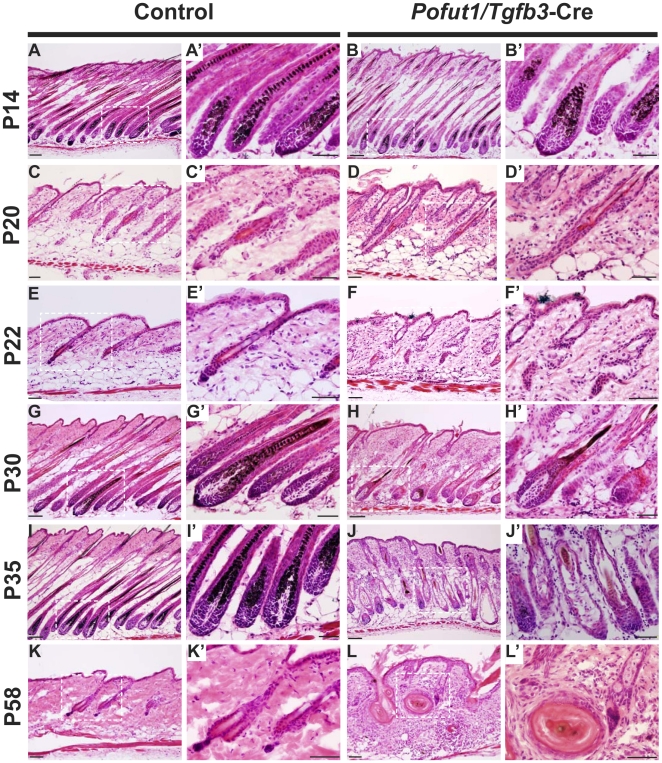

Pofut1/Tgfb3-Cre hair follicles display aberrant telogen morphology and have defects in hair follicle maturation.H&E stained back skin sections from control littermates (A, C, E, G, I, K) and Pofut1/Tgfb3-Cre mice (B, D, F, H, J, L) at P14 (first anagen), P20 (first catagen), P22 (first telogen), P30 (second anagen), P35 (second anagen), and P58 (second telogen). The boxed regions in (A–L) are shown at high magnification in the corresponding right panel (A′–L′). Hair follicles of Pofut1/Tgfb3-Cre mice displayed impaired differentiation (H) and subsequently turned into empty shells filled with keratinized materials (J). Most of the mutant hair follicles were converted to epithelial cysts at the end of the second hair cycle (L). The epidermis of Pofut1/Tgfb3-Cre mice exhibited progressive hyperplasia and hyperkeratosis. Scale bar, 100 µM in A, B, G, H, I, J; 50 µM in the rest of the panels.